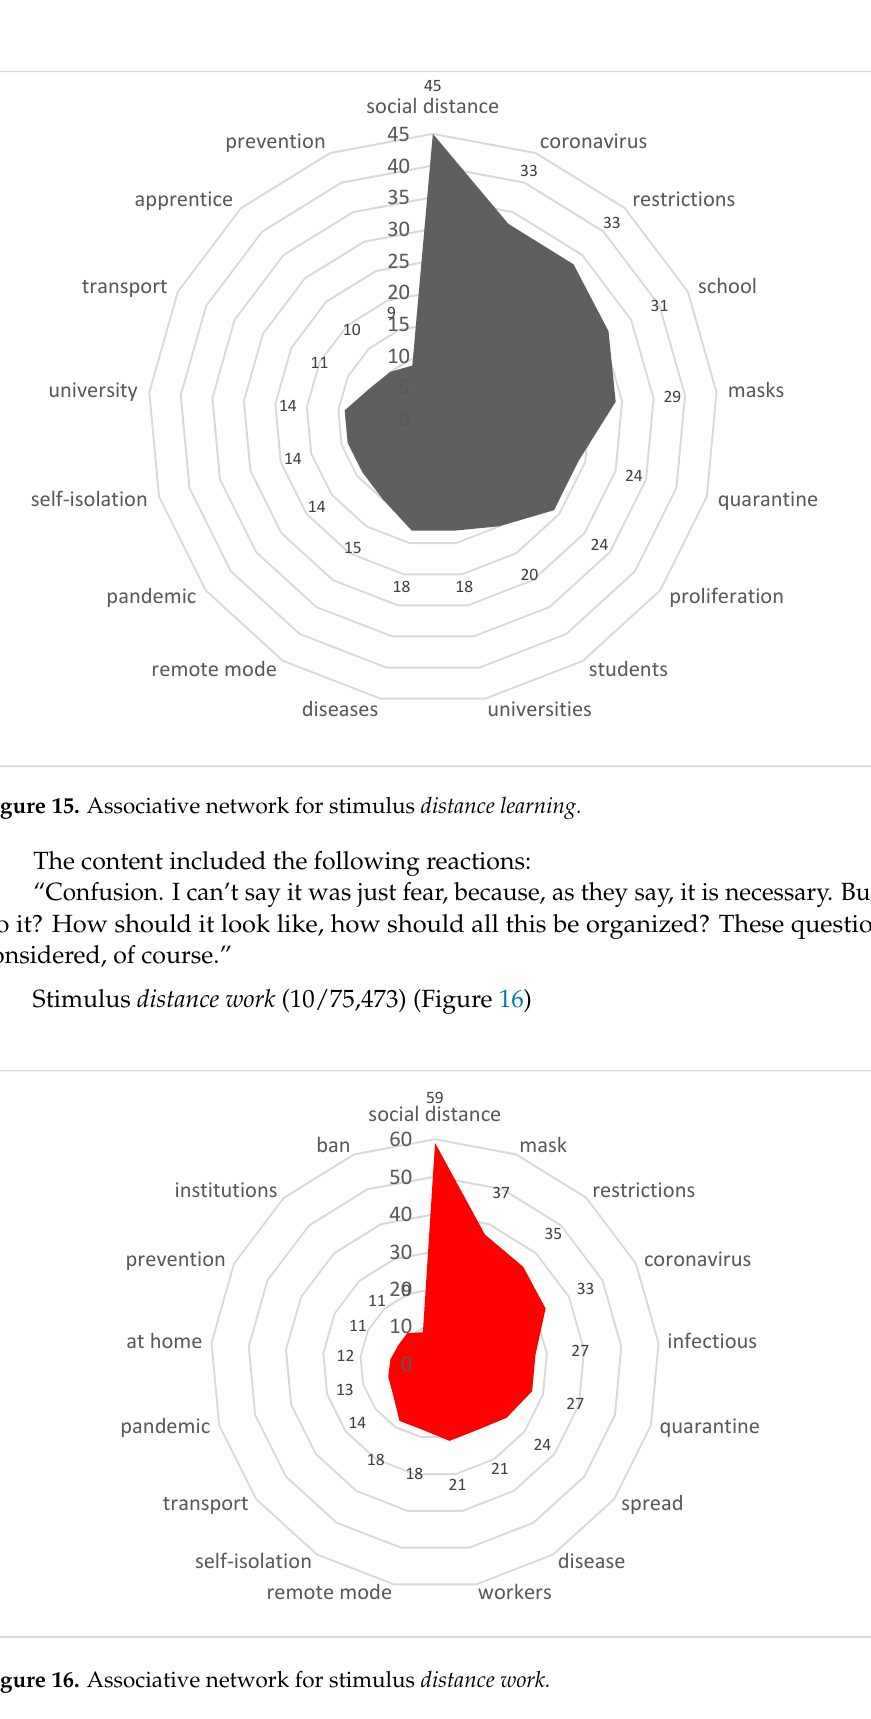
Figure 16. Associative network for stimulus distance